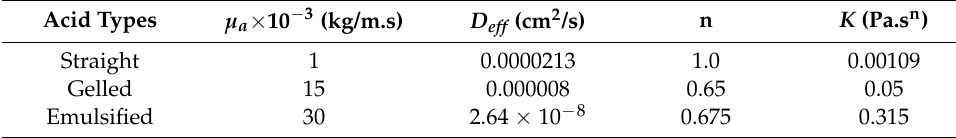
Figure 12. The impact of fluid viscosity on the of flow rate ( a ) and acid volume ( b ) for a 540 bbl acid volume. Table 3. Property of three acid systems types studied [37].